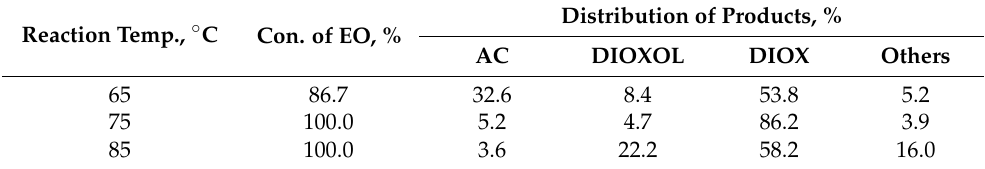
Table 2. Effect of GHSV.